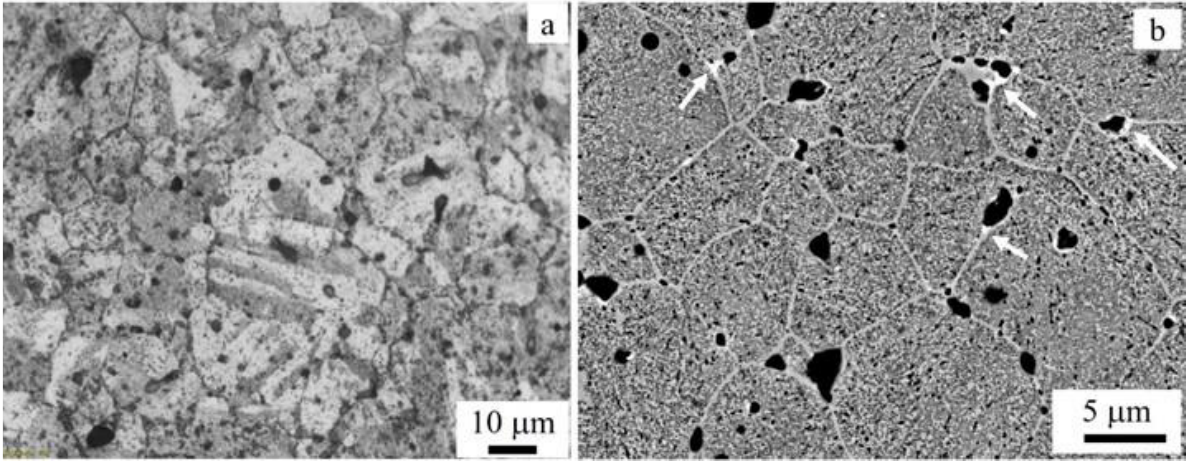
Figure 7. The microstructure of MfMX-17-4 AP stainless steel: ( a ) LOM and ( b ) SEM (back-scattered electron image).